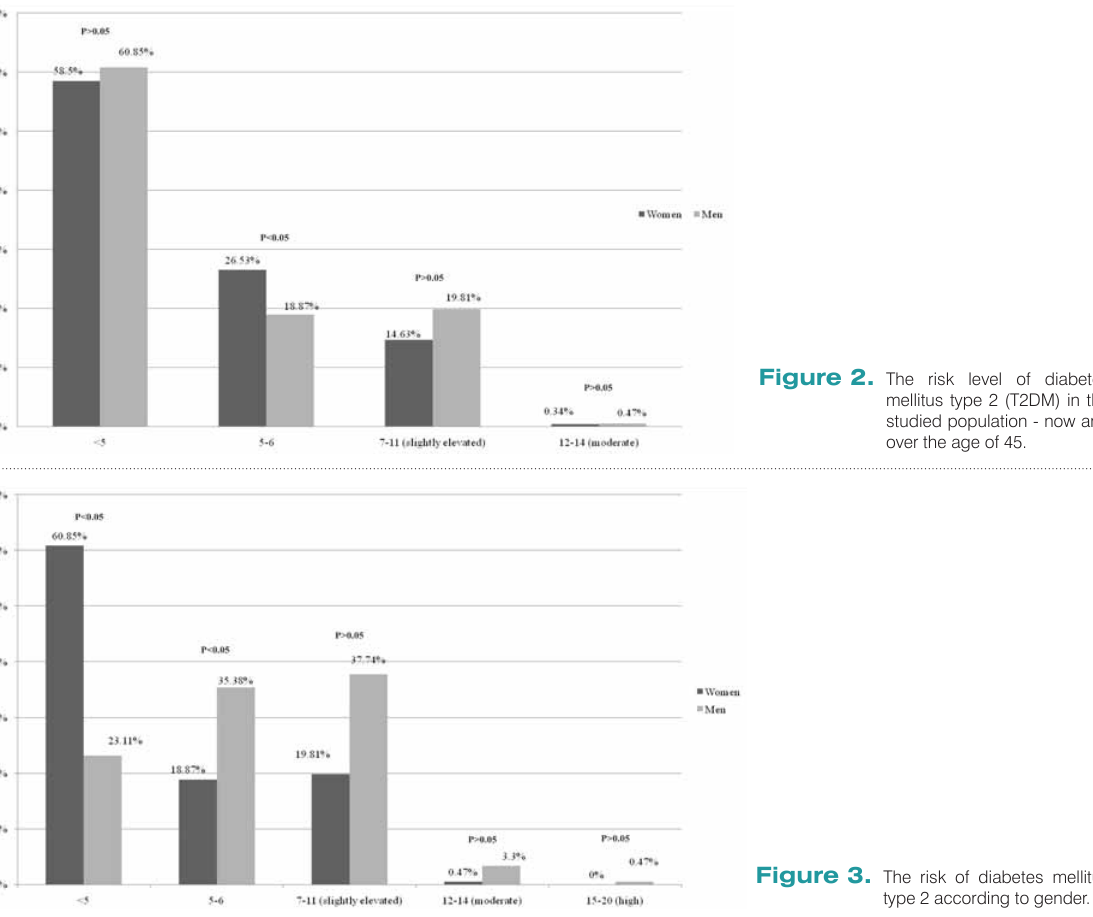
Figure 2. The risk level of diabetes mellitus type 2 (T2DM) in the studied population - now and over the age of 45.